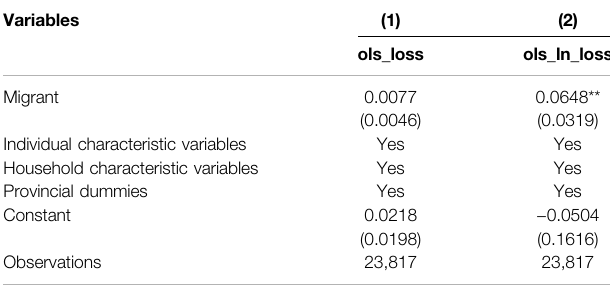
TABLE 6 | The robustness check of risk of households being defrauded on migrant status (excluding samples that started their current works in less than 1 year).